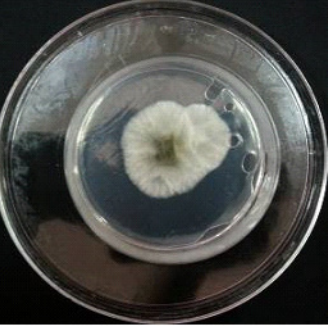
Fig. 7 (B). Mycelium growth of Alternaria alternata After adding 5 ml of distilled water (in the outer dish) and incubated for one week at 27°C